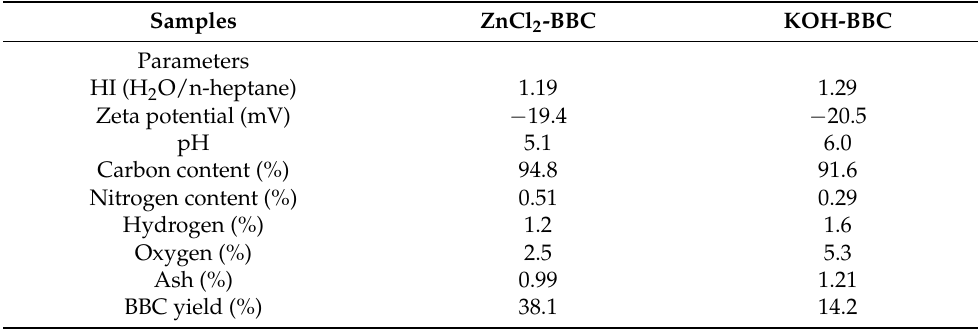
Table 4. Properties and elementary analysis of activated carbons.